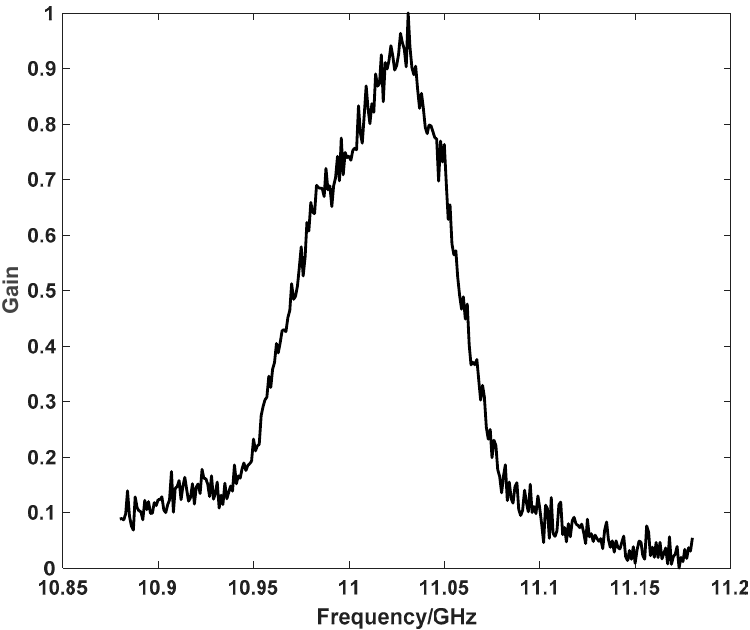
Figure 9. Experimental BGS obtained through BOTDA. The starting frequency of BGS is 10.88 GHz, the ending frequency is 11.19 GHz, and the step is 1 MHz.